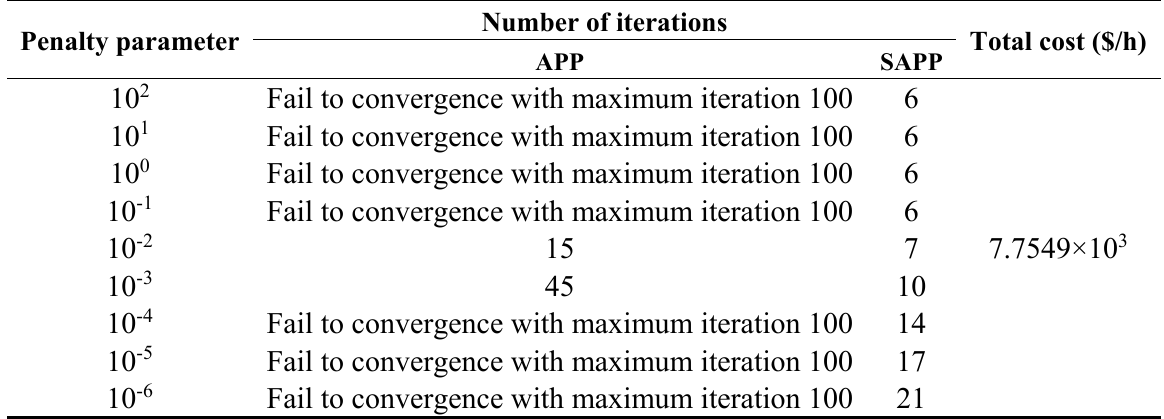
Table 1. Comparison of results for test system 1.